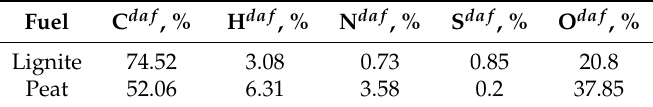
Table 1. Results of the chemical analysis of peat and